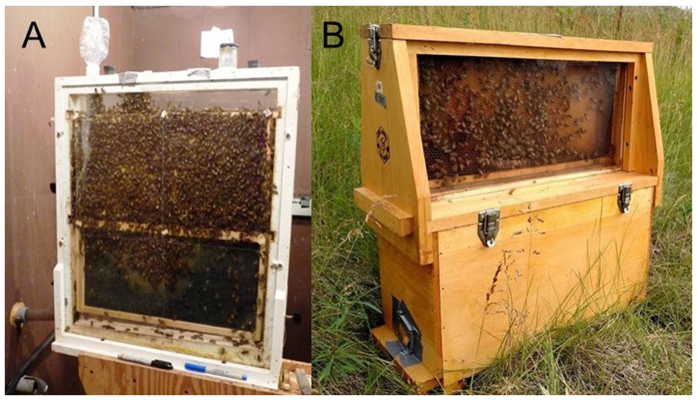
Observation hives used for 1-frame and 2-frame experimental hives containing 1500 and 3000 worker bees and a laying queen, respectively (A). Ulster (U501) observation hive for 5-frame experimental hives containing roughly 7000 worker bees and a laying queen. The frame containing the laying queen was placed in the upper level during observation periods while the other four frames and a feeder remained in the lower portion of the box. The entrance of the hive is located in the lower level and is shown taped closed in this picture (B).